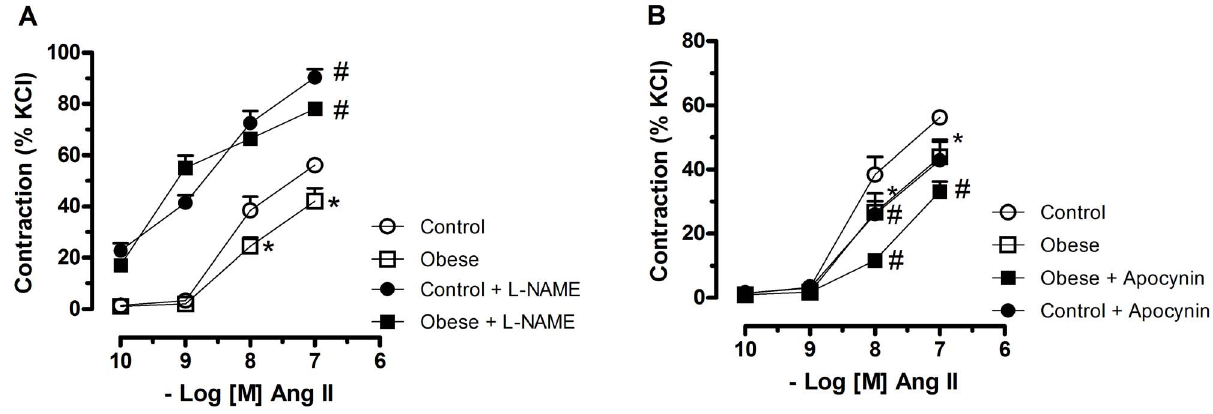
Figure 3. Contribution of nitric oxide and NADPH oxidase to the vascular effects of angiotensin. Mesenteric arteries with intact endothelium from control and monosodium glutamate-induced obese rats were pretreated with N v -nitro-L-arginine methyl ester (L-NAME, 100 m M), a nitric oxide synthase inhibitor ( A ) or apocynin (100 m M), a NADPH inhibitor ( B ) for 30 min and non-cumulative concentration–response curves to angiotensin II (ANG II) were obtained. Each point represents the mean 6 SEM. *, P , 0.05 vs. Control. # , P , 0.05 vs. respective group in the absence of blockade. N= 6/group.